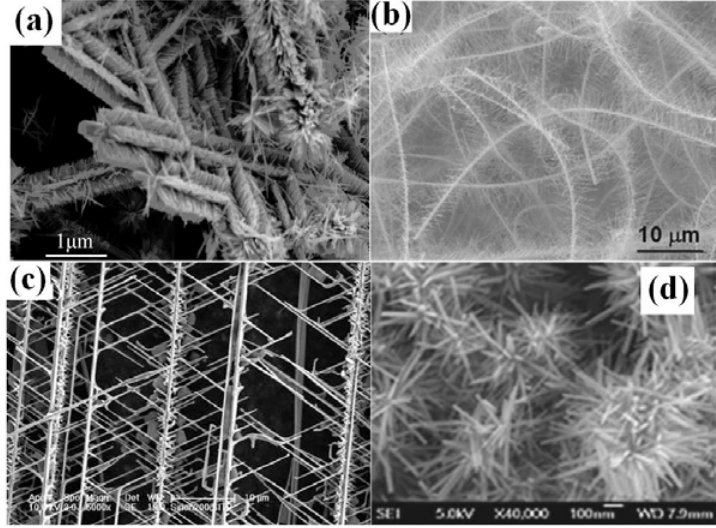
Figure 6. (a) SEM images of ZnO brushes [67]. (b) SnO (d) ZnO nanoflowers [69].